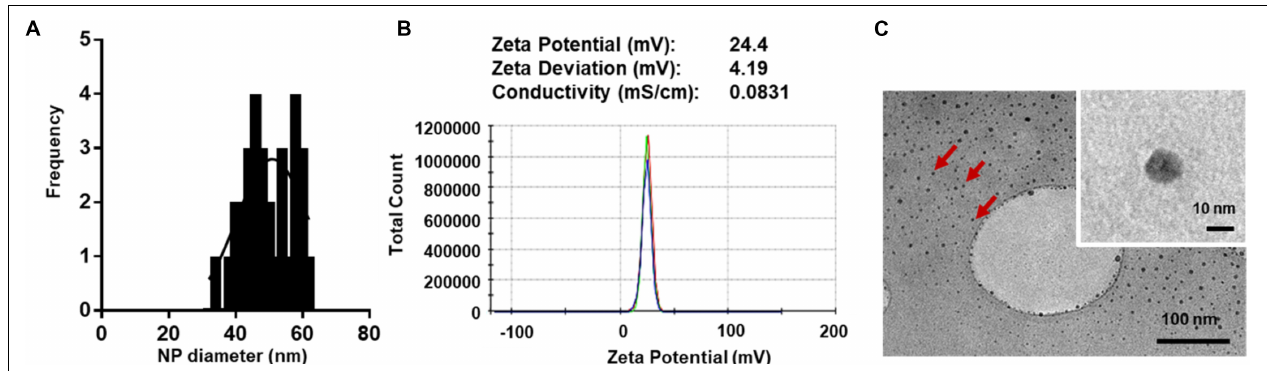
FIGURE 1 | Characteristics of pDNA-PLL NPs. (A) NP size measured with Zetasizer Nano shows relatively small and homogenous distribution of NPs. (B) An image of a Zeta potential report indicates positive surface charge of NPs. The NPs were prepared and measured in nuclease free water; the same condition used for encapsulation in the double emulsion process. (C) TEM images demonstrate size and morphology of the same NPs. Red arrows highlight individual NPs.